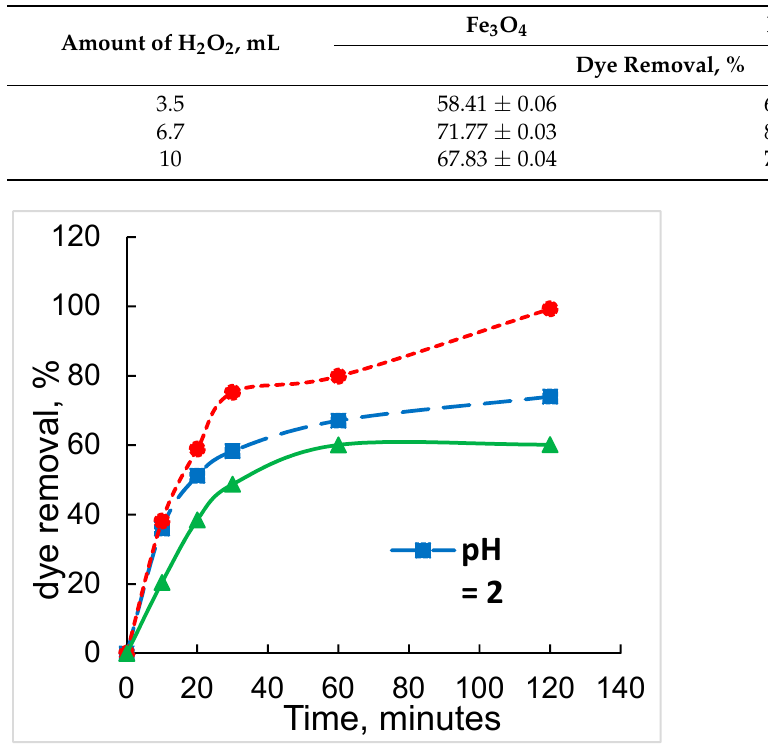
Figure 6. Effect of pH on the photocatalytic degradation of Methyl Orange under the following conditions: initial dye concentration of 5 × 10 − 4 mol · L − 1 , the concentration of H 2 O 2 = 30%, and room temperature of 23 ± 2 °C.